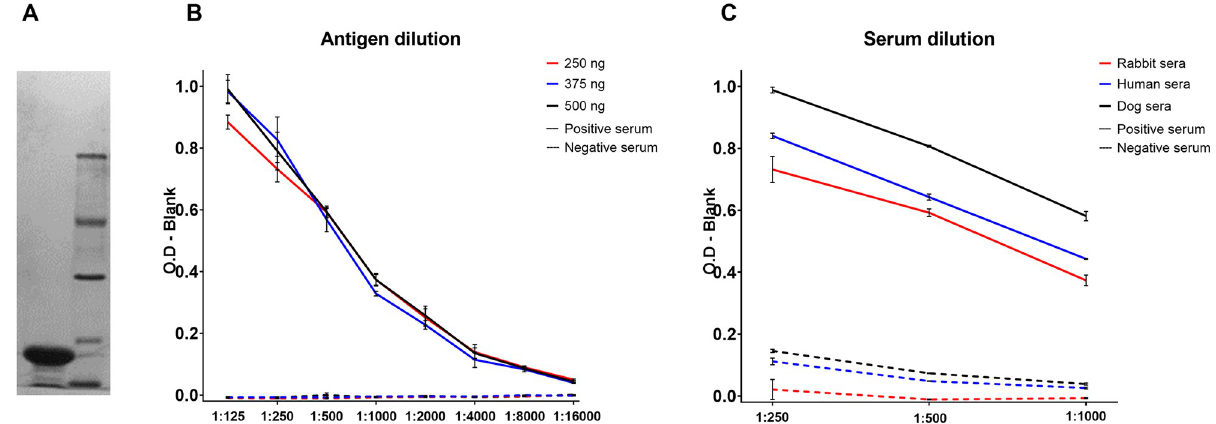
Fig 1. Standardization of Protein A-ELISA. F1 antigen purified from the A1122 Y . pestis strain in culture (A) . Three concentrations of F1 antigen (250 ng, 375 ng and 500 ng) were tested. The assay was optimized at the concentration of 250 ng of F1 antigen per well (B) . Graph with the optical densities from titrated sera in different species (C)